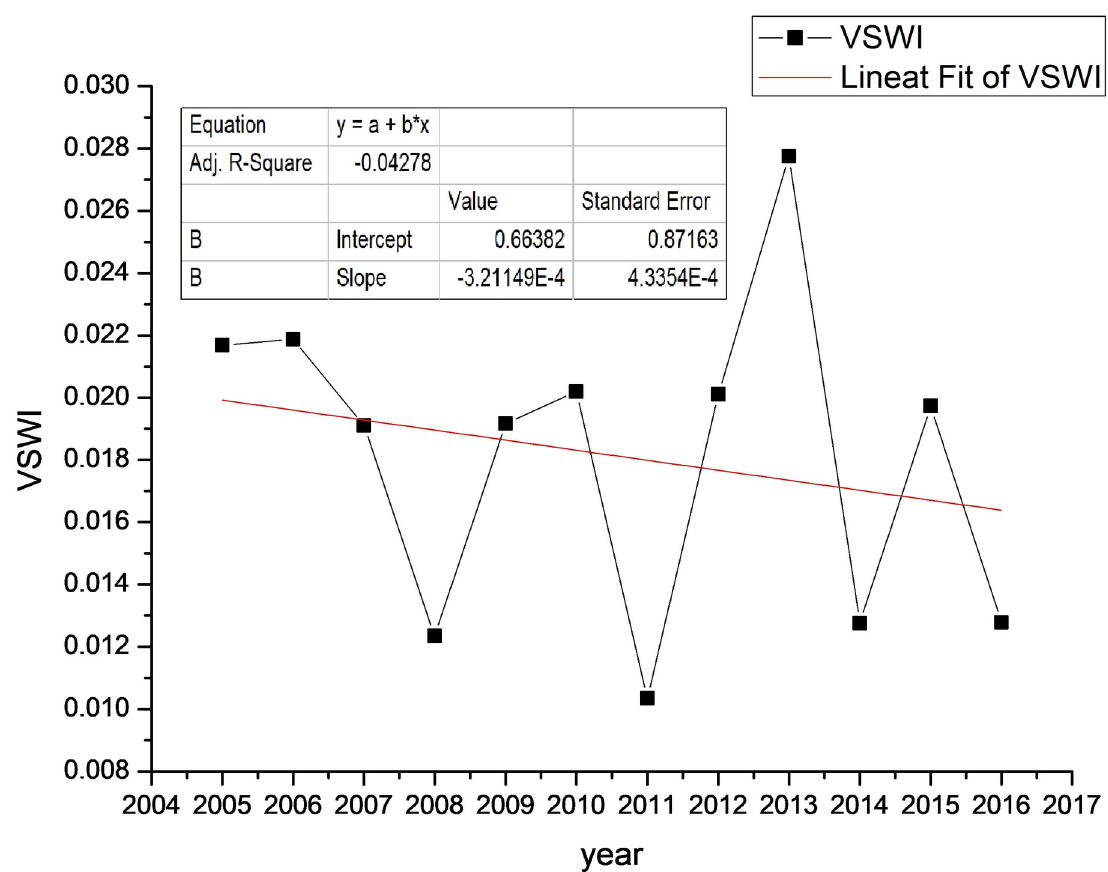
Fig 6. Overall average VSWI by year in the study